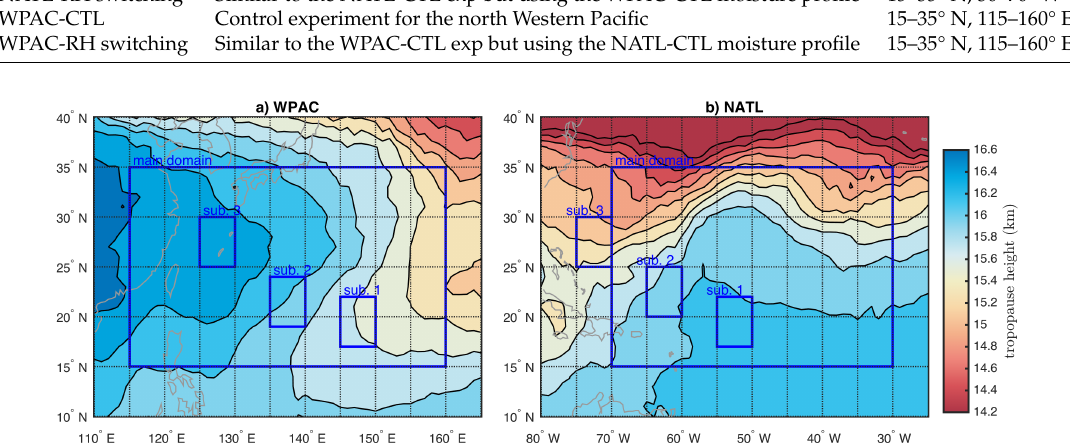
Figure 1. Illustrations of two main domains (large boxes) in the WPAC and NATL basins in the CTL experiments, and three corresponding subdomains (small boxes) used in the sensitivity experiments. Filled contours denote the tropopause height